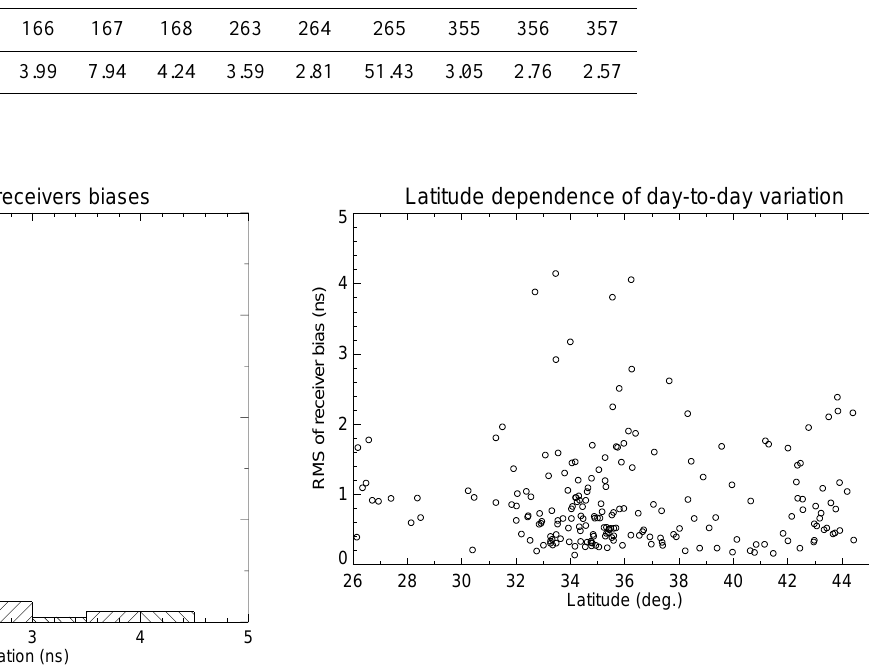
Table 1. The standard deviation of residual ( χ g ) from the GEONET-based method for the 9 days in 2001. The numbers in the first row refers to the day of year 2001. The unit of χ g is in TECU